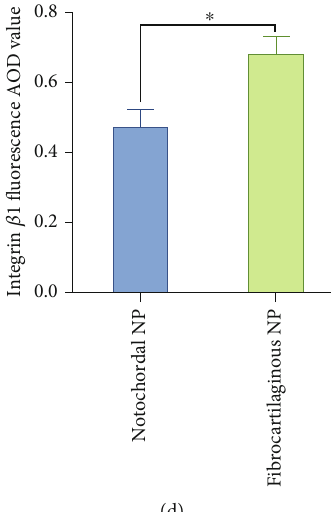
Figure 6: Di ff erential expression of N-CDH and integrin β 1 in the rabbit notochordal NP and fi brocartilaginous inner AF: (a) N-CDH (red) and integrin β 1 (green) fl uorescent staining of rabbit notochordal NP (200x); (b) statistic analysis of fl uorescent N-CDH AOD value of the notochordal NP and fi brocartilaginous inner AF; (c) N-CDH (red) and integrin β 1 (green) fl uorescent staining of rabbit fi brocartilaginous inner AF (200x); (d) statistic analysis of fl uorescent integrin β 1 AOD value of the notochordal NP and fi brocartilaginous inner AF. ∗ P < 0 : 05 . Scale bar = 100 μ